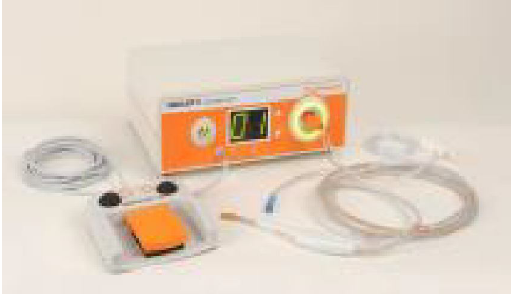
Hydrosurgery debridement Figure 15. Using high-pressure saline jet to remove devitalised tissue.